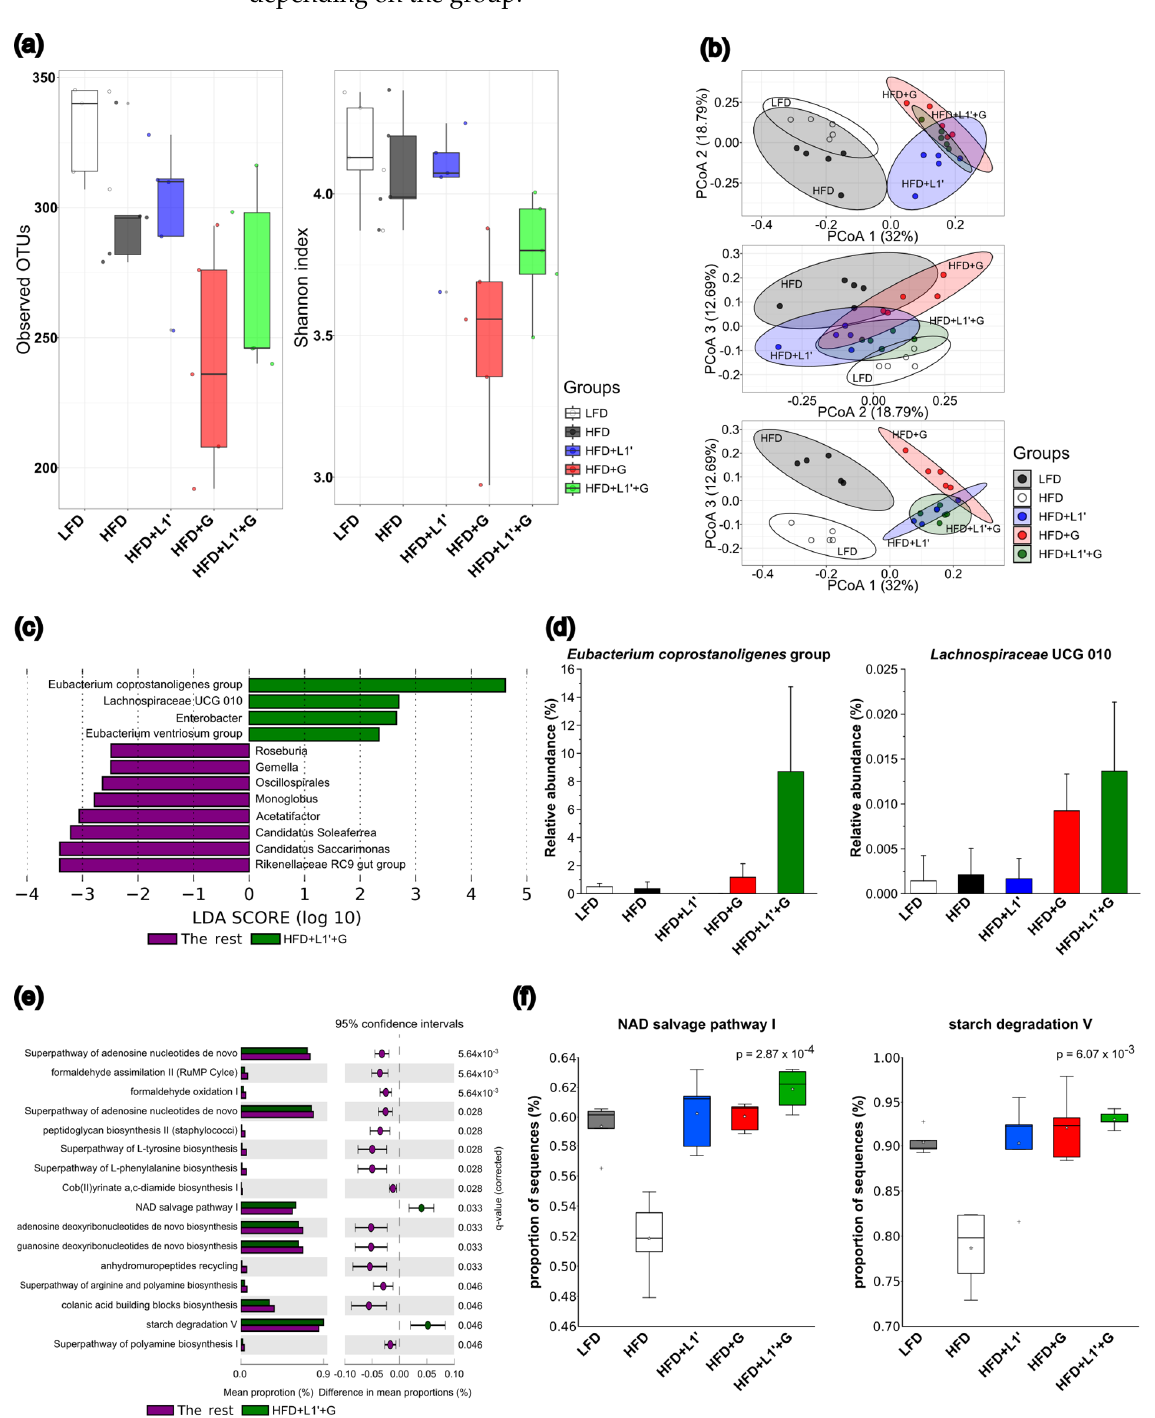
Figure 5. The combination of L. plantarum HAC03 and G. cambogia affect gut microbiota modulation. ( a ) alpha diversity. ( b ) beta diversity. ( c ) Linear discriminant analysis (LDA) effect size (LEfSe) with LDA effect size ≥ 2 and alpha ≤ 0.05 for HFD + L1 (cid:48) + G group. ( d ) gut microbiota related HFD + L1 (cid:48) + G group. ( e ) Functional potential prediction of HFD + L1 (cid:48) + G group and the rest. ( f ) Specific functions correlated HFD + L1 (cid:48) + G group. The data presented as mean ± SD ( n = 5). Significance for data is calculated using a one-way ANOVA followed by a Bonferroni multiple comparison